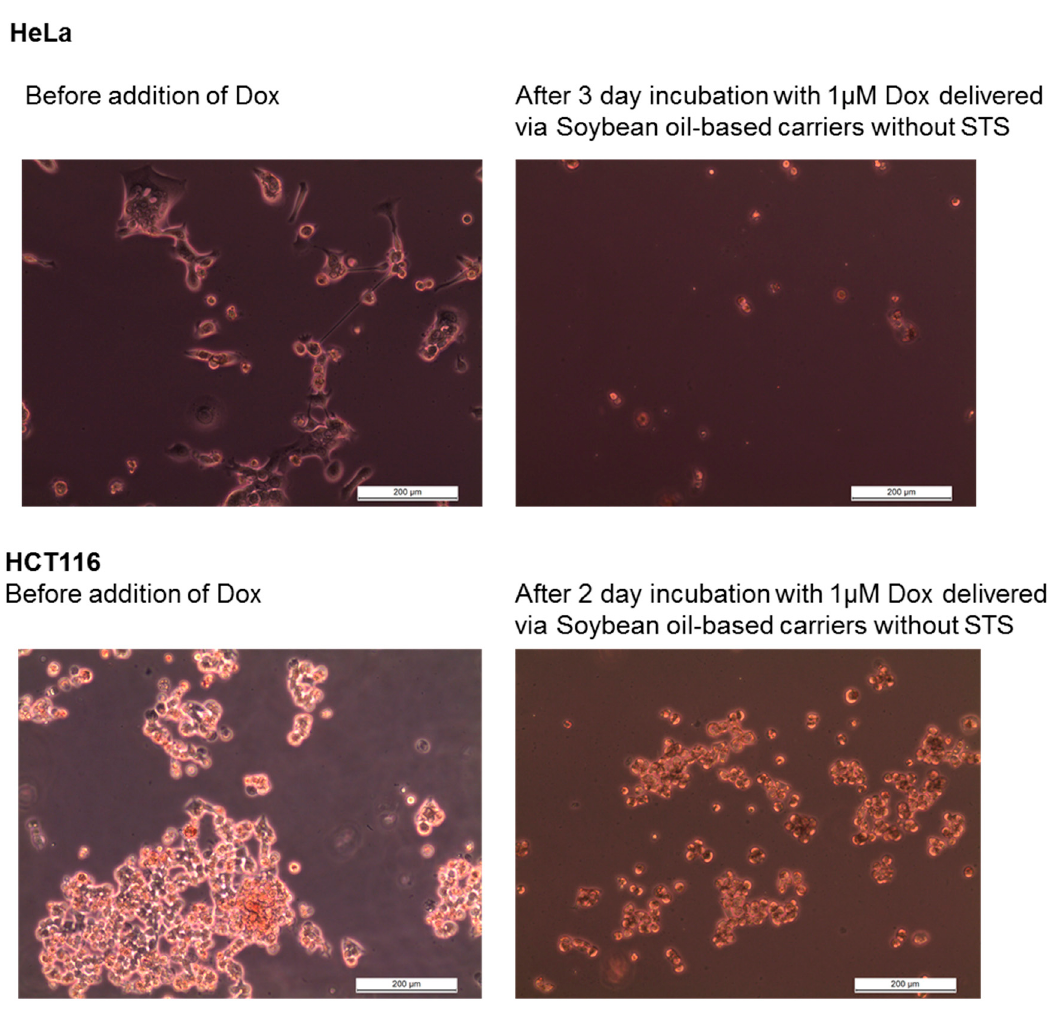
Figure 4. The viability of HeLa and HCT-116 cells is reduced after exposure to Dox soybean oil-based carrier systems. Shown here are phase contrast images with focus on adherent cells of HeLa (top panel) and HCT116 cultures (bottom panel) before and after exposure to 1 µM of Dox delivered via soybean oil-based carriers without STS. These images were taken before cells were harvested for the determination of the survival using the Casy TT system, as described in the Methods section. Note the changed morphology in response of the treatment with Dox. The results of the quantification are shown in Figure 5.